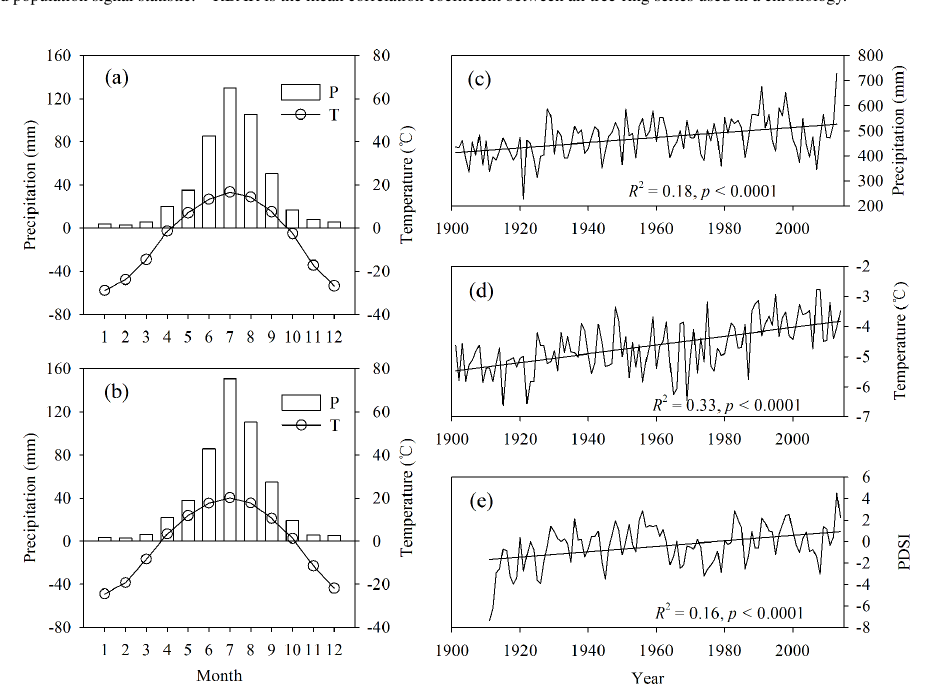
Figure 2. Monthly total precipitation ( P ) and mean temperature ( T ) at the Xiaoergou meteorological station (1957–2014) (a) and grid data (1901–2014) (b) ; the annual total precipitation (c) , the annual mean temperature (d) and PDSI (e) . The dashed line indicates the linear fitting